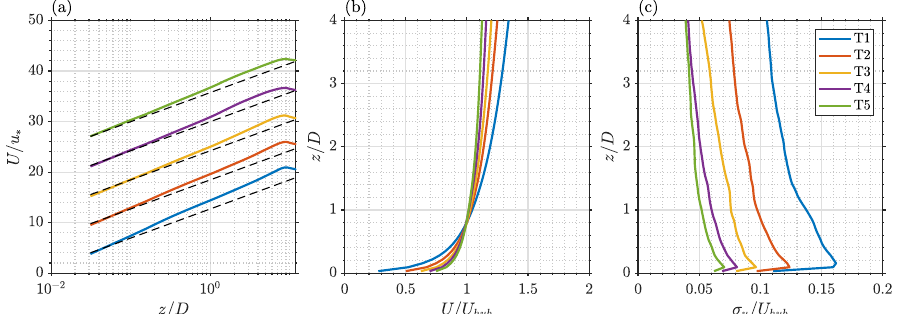
Figure 1. Inflow characteristic for test cases: ( a ) vertical profiles of the mean streamwise velocity normalized with the friction velocity ( u ∗ ) compared to the log law (dashed line); ( b ) vertical profiles of the normalized mean streamwise velocity in linear scale; ( c ) vertical profiles of the mean streamwise turbulence intensity.